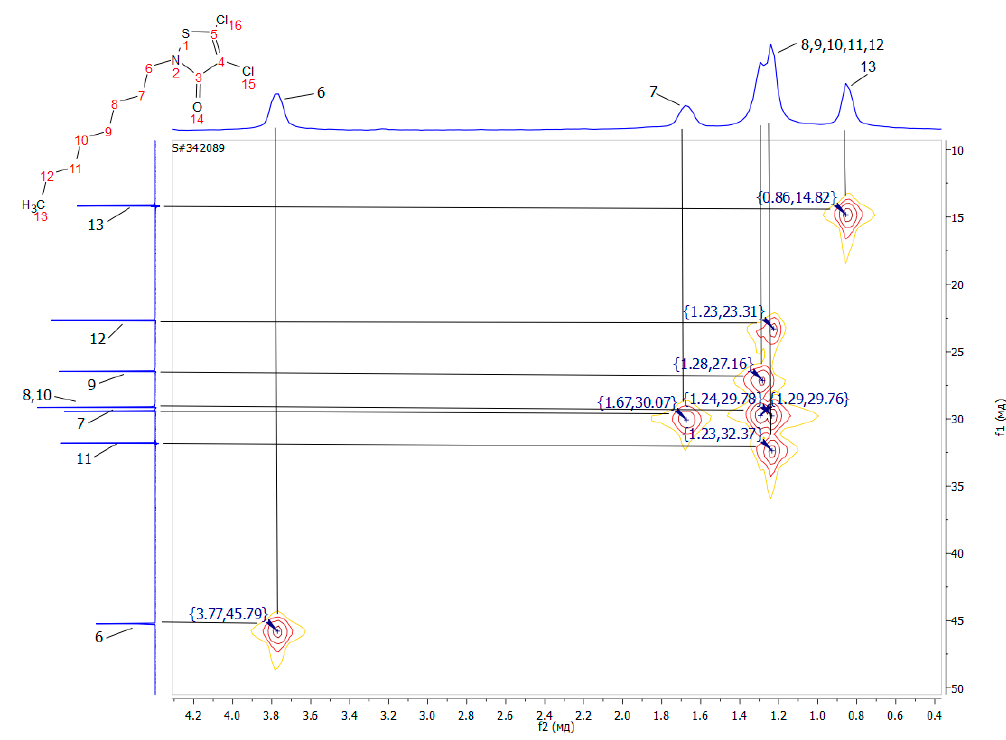
Figure 7. HMQC spectrum of a sample of DCOIT.